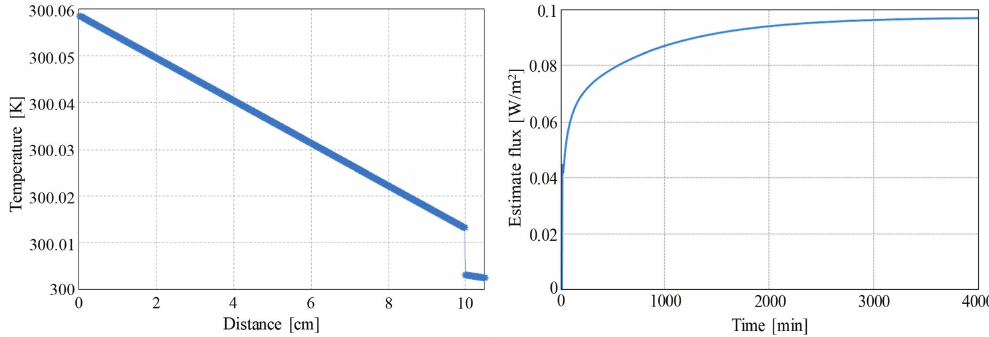
Figure 8. Open loop simulation results with a contact resistance of 0.1 K/(W/m 2 ) and heat losses of 500 W/(m 3 K). ( Left ) final temperature distribution in the complete structure. ( Right ) Estimated heat flux in the thermopile. The heat flux injected at the left of the structure is 0.1 W/m 2 .